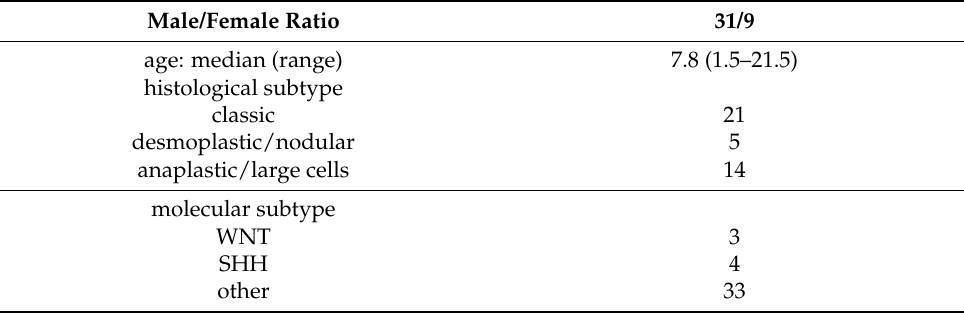
Table 5. Clinicopathological characteristics of